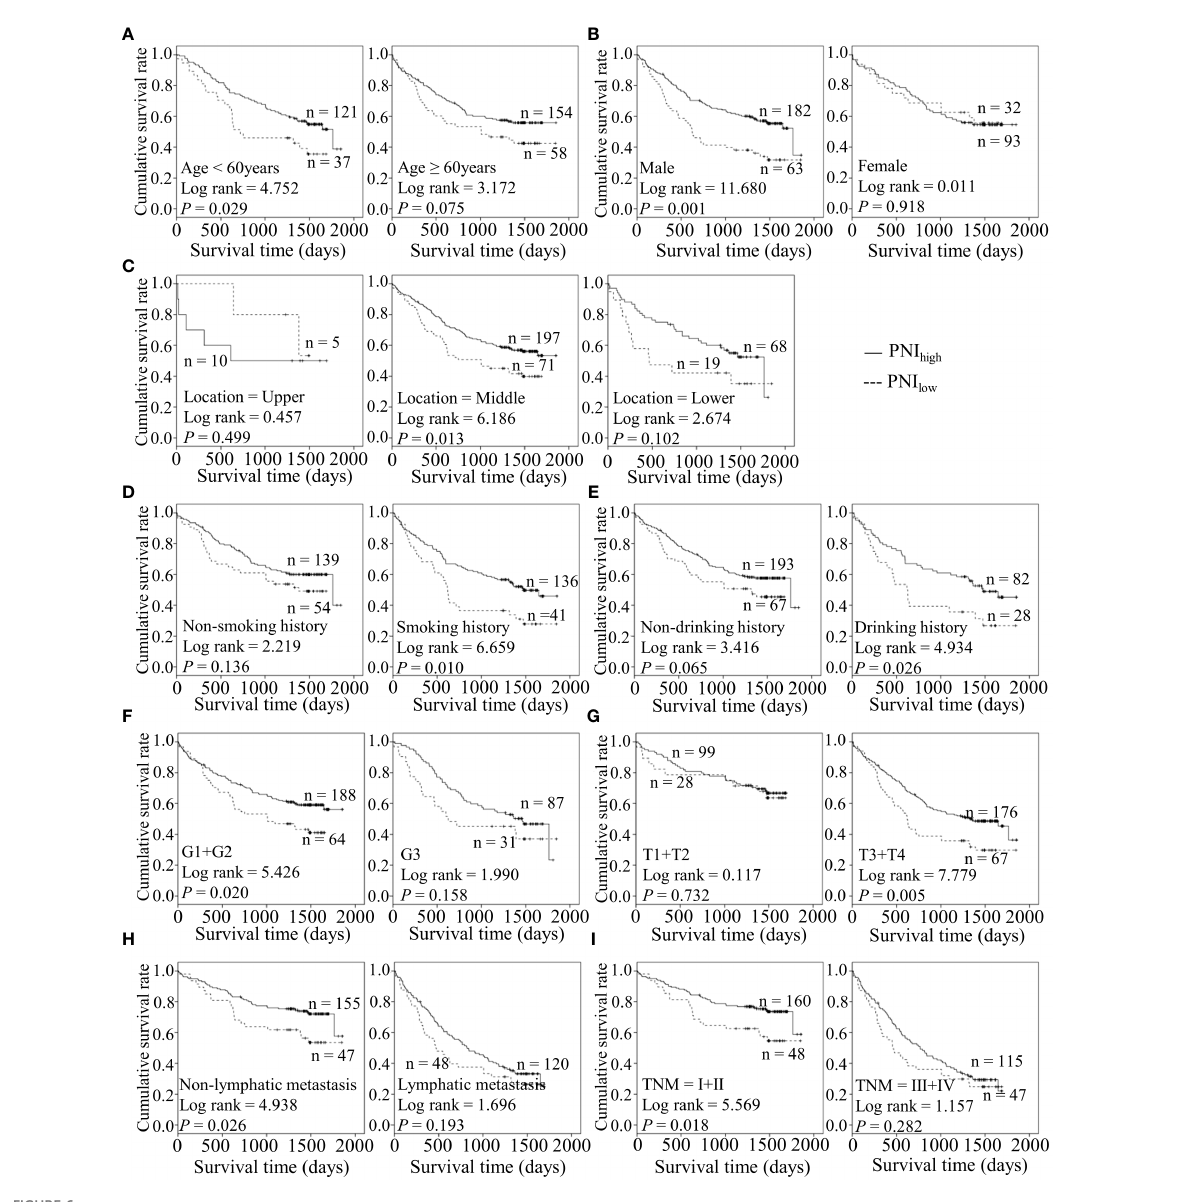
FIGURE 6 Predicating role of preoperative PNI level for the OS of ESCC patients. (A – I) Kaplan-Meier survival curves of ESCC patients with different PNI levels combined with diverse features like age (A) , gender (B) , tumor location (C) , smoking history (D) , drinking history (E) , tumor grade (F) , T stage (G) , lymph node metastasis (H) and TNM staging (I)